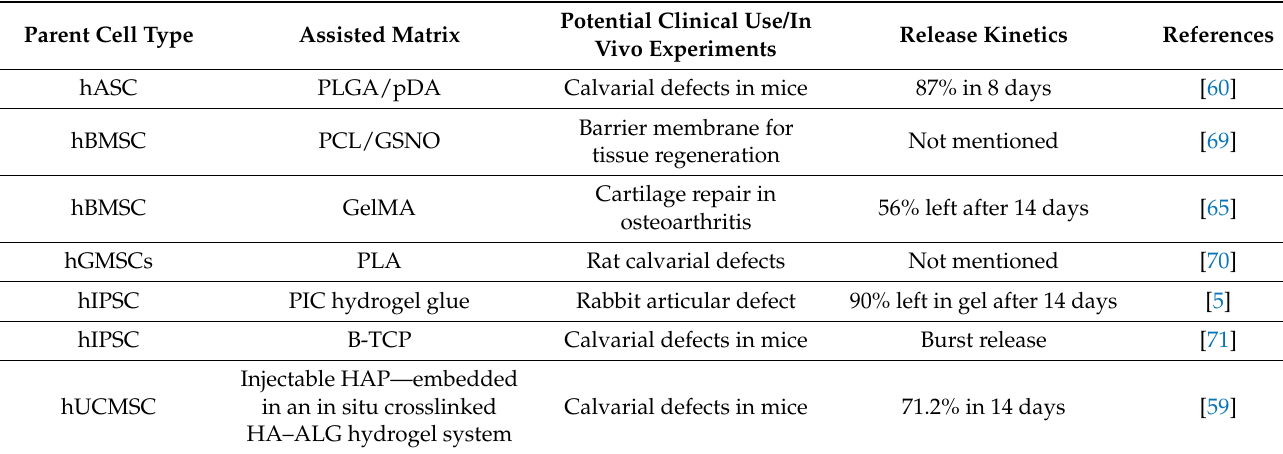
Table 2. Stems cells combined with hydrogel matrices and their corresponding clinical/in vivo uses in hard tissue